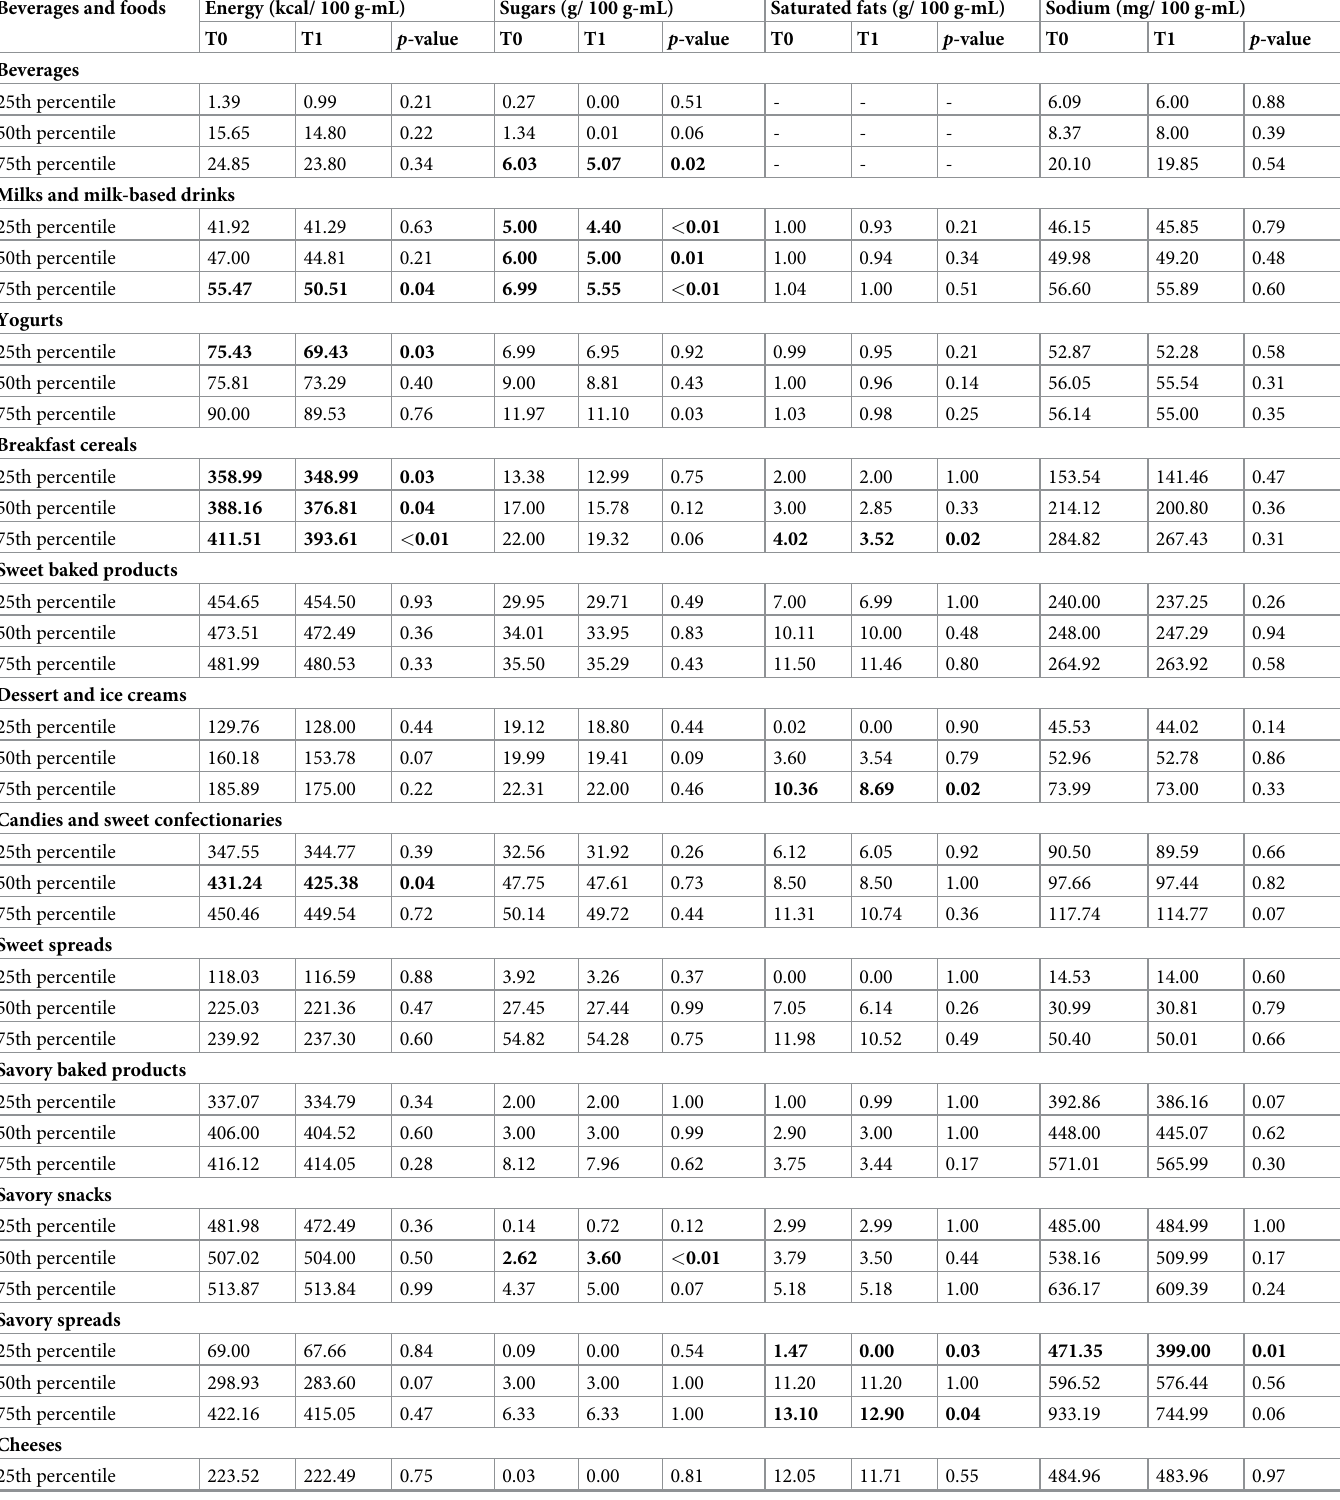
Table 4. Changes in quartiles of energy and nutrients of concern by food or beverages group, longitudinal analysis. Beverages and